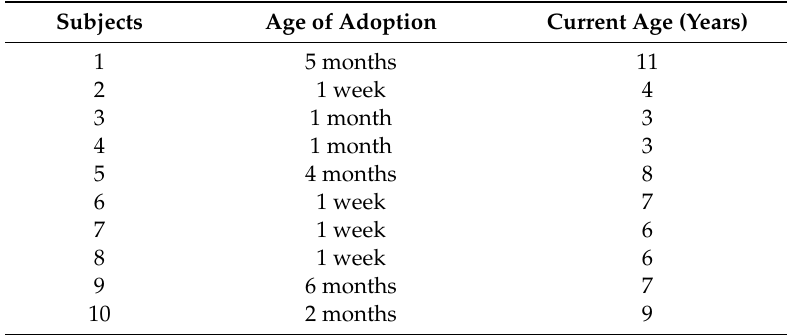
Table 1. Age of adoption and current age of the tested cats Subjects Age of Adoption Current Age